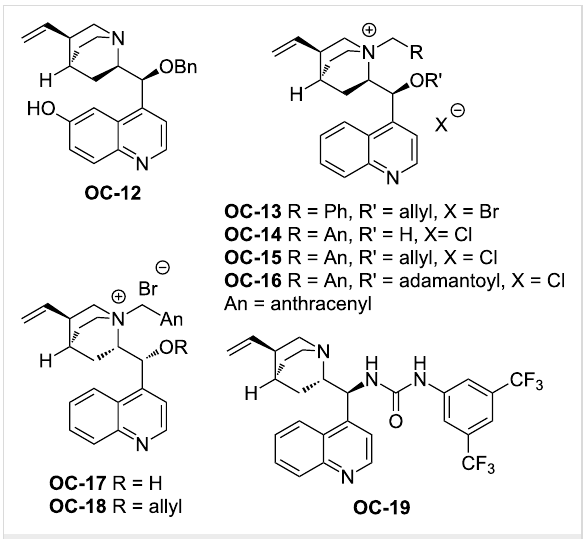
aqueous K 2 HPO 4 as base. However, under the same conditions, the PTCs with a free 9-OH ( OC-17 ) led to 13 in low yields and enantioselectivities (21% ee). The urea catalyst OC-19 proved to be very inefficient and afforded 13 in 10% yield with 6%